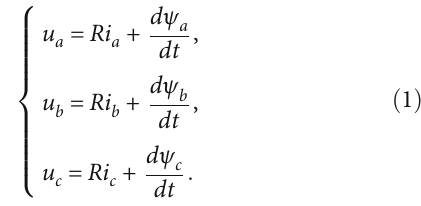
Figure 2. The axes A , B , and C refer to three-phase stationary stator coordinates. Each electric angle is 120 ° . The axes α and β refer to two-phase stationary stator coordinates. The vec- tor diagram between two-phase stationary stator coordinates and two-phase rotating rotor coordinates is shown as Figure 3. The axes d and q refer to two-phase rotating rotor coordinates. According to rotor fi eld-orientated control, d is the axis where the rotor locates, and the axis q gets ahead 90 ° of the axis d in an anticlockwise direction. The axis d and q rotate at rotor angular speed ω r in an anticlockwise